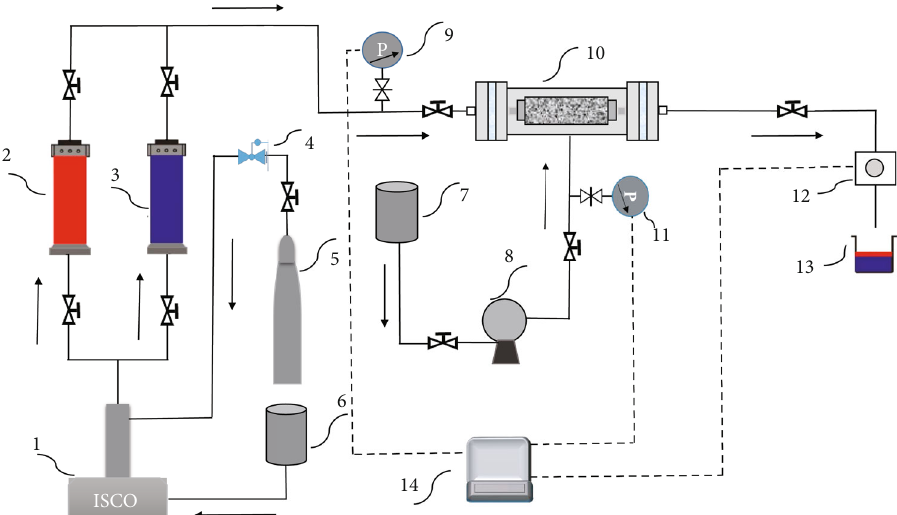
Figure 3: Schematic of the core fl ow experiments. Labels: 1: ISCO pump; 2: simulated oil; 3: simulated formation water; 4: pressure relief valve; 5: nitrogen cylinder; 6 and 7: kerosene tank; 8: con fi ning pressure tracking pump; 9 and 11: pressure gages; 10: core holder; 12: fl ow meter; 13: e ffl uent container; 14: